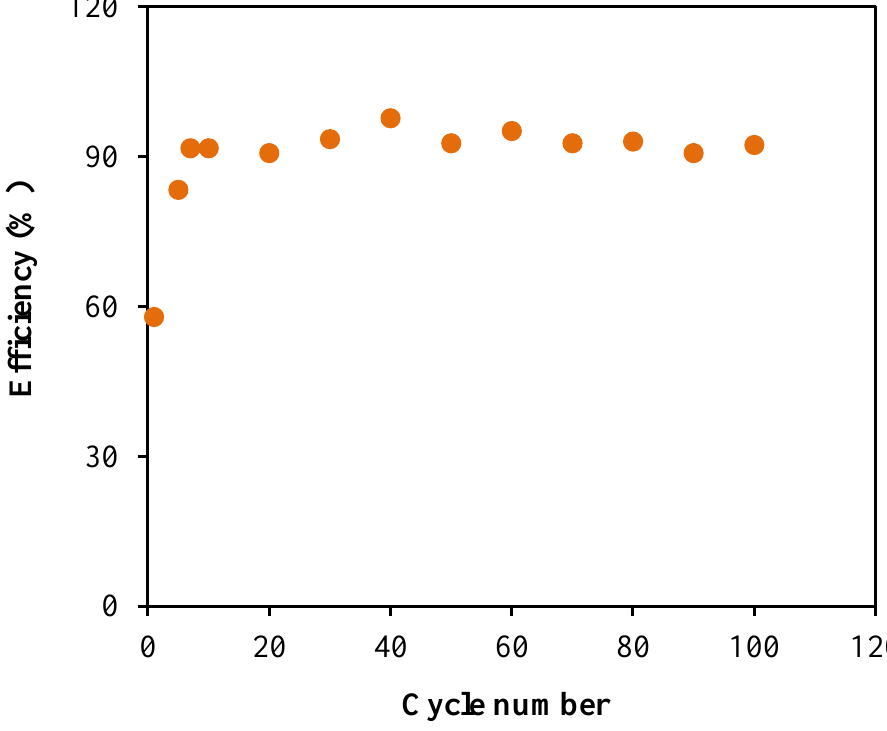
Figure 14. The efficiency 𝜂 of the fabricated EDLC. Figure 14. The e ffi ciency η of the fabricated